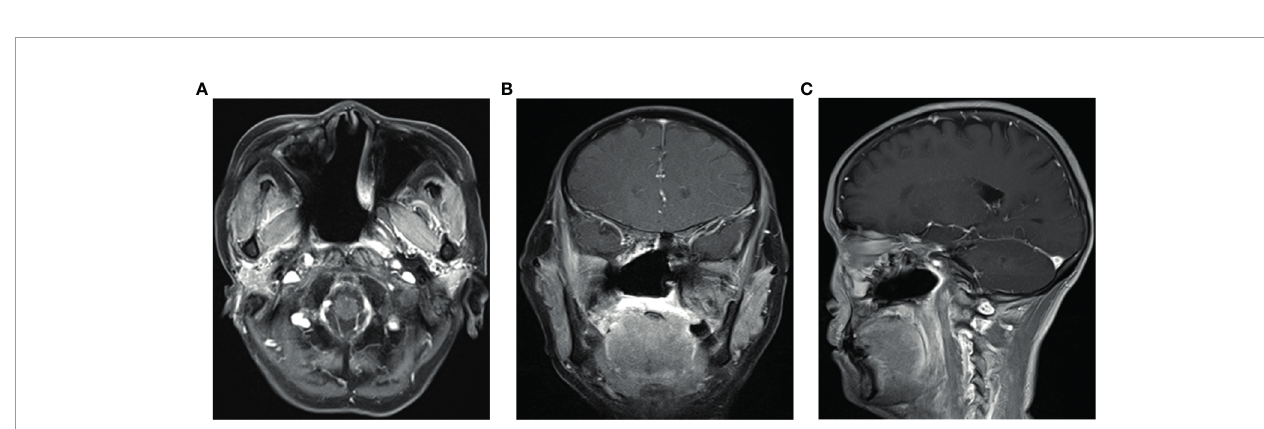
FIGURE 4 | Immunohistochemical staining of local canceration of the inverted papilloma. (A) Elevated cytoplasmic expression of VEGFR-2 with color brown in solid nests (×100); (B) Elevated cytoplasmic expression of VEGFR-2 with color brown in solid nests